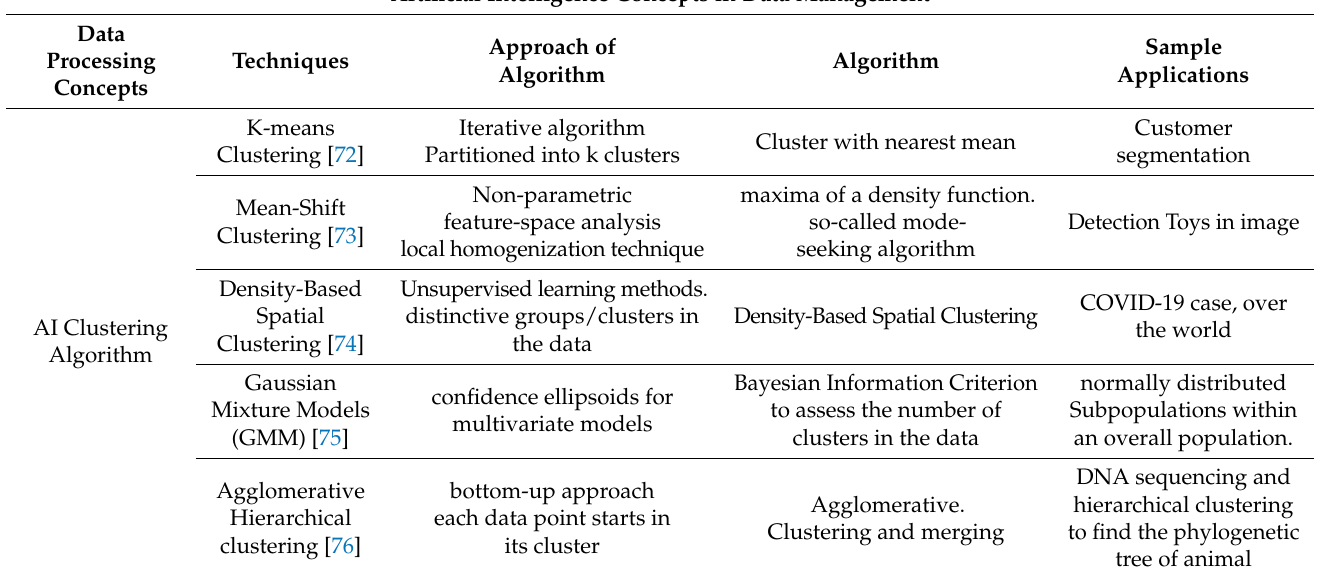
Table 5. Summary of various artificially intelligent